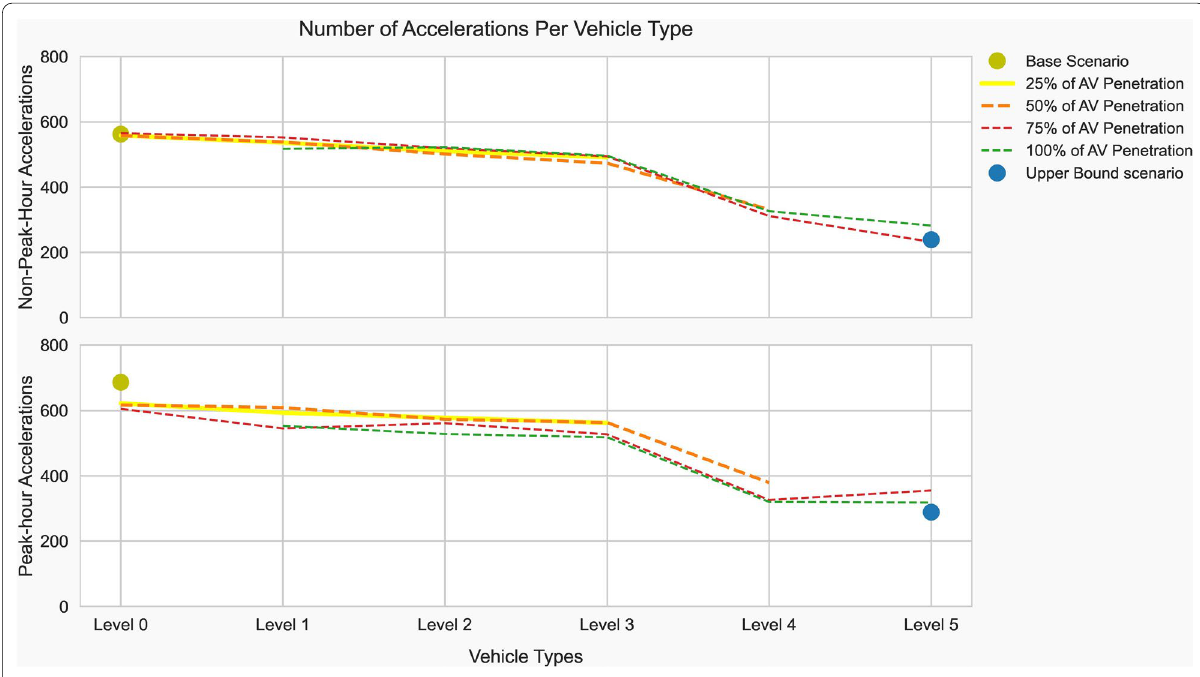
Fig. 7 The total number of vehicle accelerations